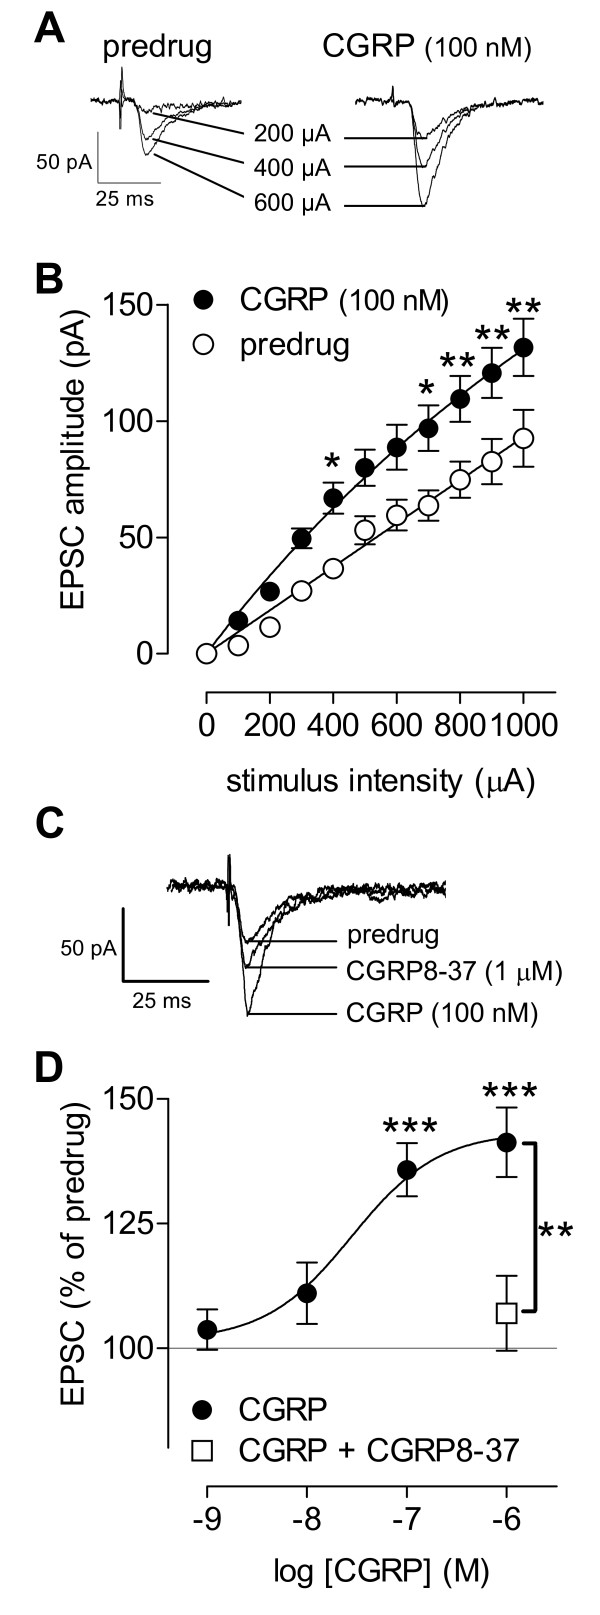
CGRP enhances synaptic transmission in the CeLC in slices from normal animals. (A) Monosynaptic EPSCs evoked at the PB-CeLC synapse with increasing stimulus intensities before and during CGRP (100 nM, 12 min). Individual traces are the average of 10 EPSCs. (B) CGRP (100 nM, 10-14 min) increased input-output function of the PB-CeLC synapse significantly (n = 10, P < 0.0001, F1,198 = 67.97, two-way ANOVA). Input-output curves were generated by plotting peak EPSC amplitude (pA) as a function of afferent fiber volley stimulus intensity (μA). (C) Synaptic facilitation by CGRP was blocked by co-administration of a CGRP1 receptor antagonist (CGRP8-37, 1 μM). Individual traces are the average of 8-10 EPSCs. (D) Cumulative concentration-response relationship of CGRP effects on synaptic transmission at the PB-CeLC synapse (n = 15). Peak amplitudes of monosynaptic EPSCs were averaged for each concentration of CGRP and expressed as percent of predrug control (set to 100%). Concentration-response curve was obtained by non-linear regression analysis using the formula y = A+(B-A)/[1+(10C/10X)D], where A is the bottom plateau, B top plateau, C = log(IC50), and D is the slope coefficient (GraphPad Prism software). CGRP8-37 (1 μM, n = 6) blocked the effect of CGRP (100 nM). CeLC neurons were recorded at -60 mV in slices from naïve untreated animals. Symbols and error bars represent mean ± SEM. *, **, *** P < 0.05-0.001 (Bonferroni posttests).